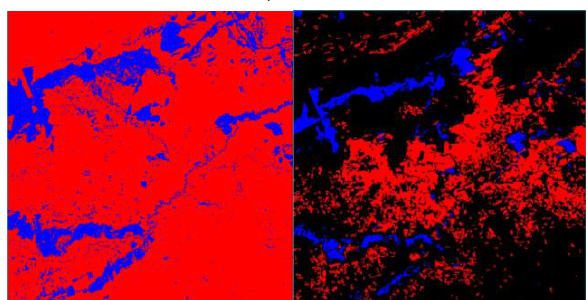
Figure 5. Changes detection map obtained from workflow method, blue area shows increased water bodies from NDWI image (left) and classified images in 2018 and 2019